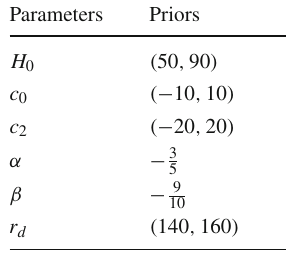
Table 1 Flat priors provided for our numerical analysis. H 0 values are given in units of Km/s/Mpc, while r d values in